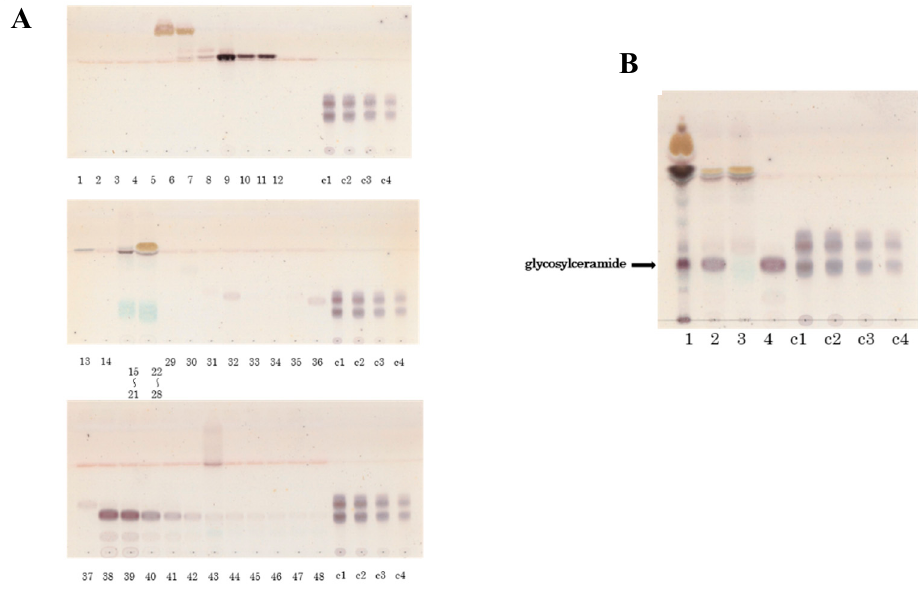
Figure 1. Glycosylceramide from mycelia of Aspergillus luchuensis using HPLC. ( A ) Purification of glycosylceramide from koji using HPLC. Lanes 1–48: Elution fractions collected during HPLC. Lanes c1, c2, c3, c4: Standard cerebroside (20 µ g, 10 µ g, 5 µ g, and 2.5 µ g, respectively). Fractions 38–42 were identified as the glycosylceramide-containing fractions. ( B ) Purified glycosylceramides. Lane 1: Total lipid fraction extracted from 0.01 g mycelia of A. luchuensis . Lane 2: Eluted fractions 11–42. Lane 3: Eluted fractions 11–37. Lane 4: Eluted fractions 38–42 (glycosylceramide fraction). Lanes c1, c2, c3, c4: Standard cerebroside (20 µ g, 10 µ g, 5 µ g, and 2.5 µ g, respectively).